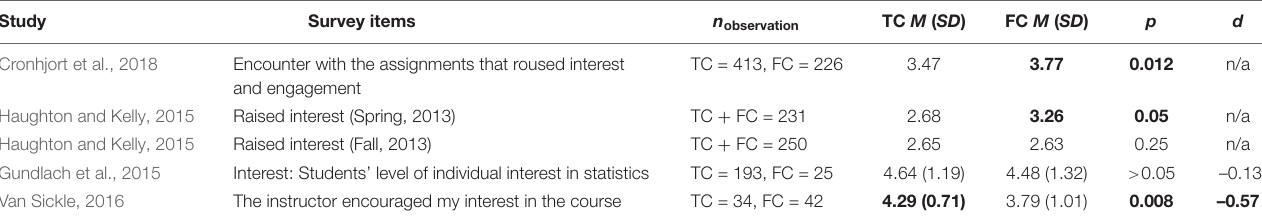
TABLE 6 | Survey results: Interest by effect size.